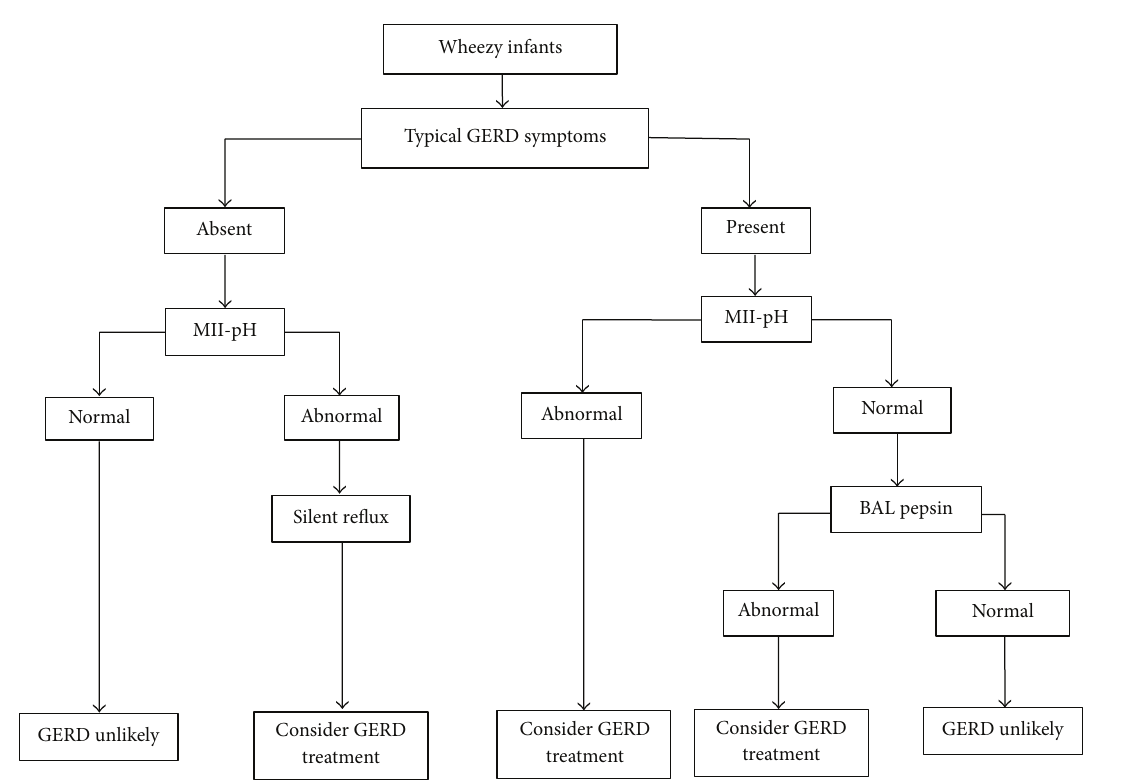
Figure 2: Stepwise approach for diagnosis of GERD associated wheezing in